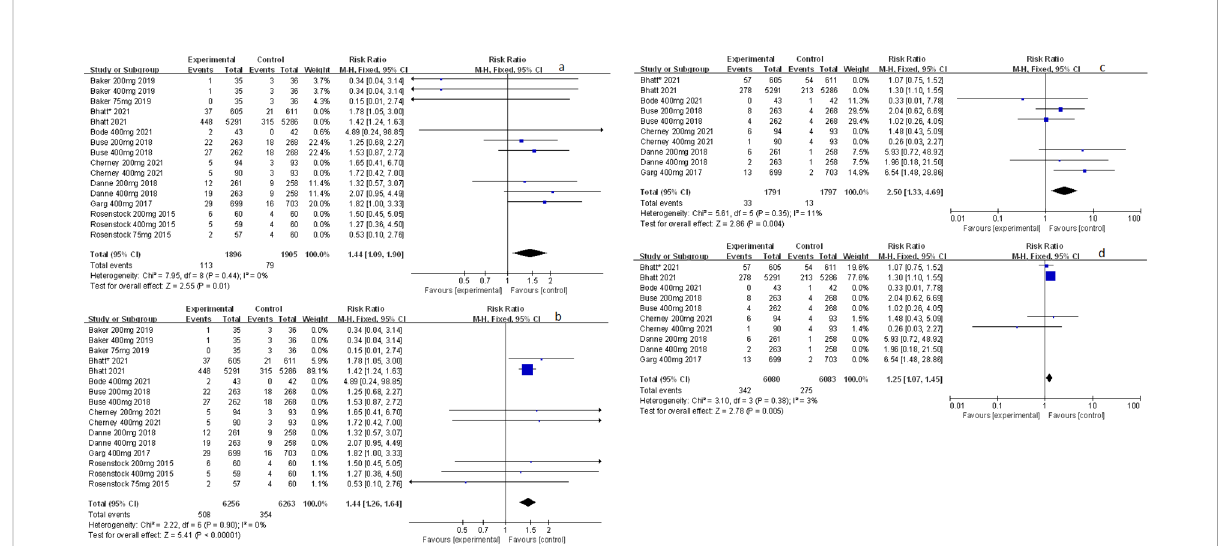
FIGURE 6 Forest plot of the other related adverse events for sotagli fl ozin versus the control group in T1D and T2D. (A) The adverse event of diarrhea in T1D. (B) The adverse event of diarrhea in T2D. (C) The adverse event of volume depletion in T1D. (D) The adverse event of volume depletion in T2D.